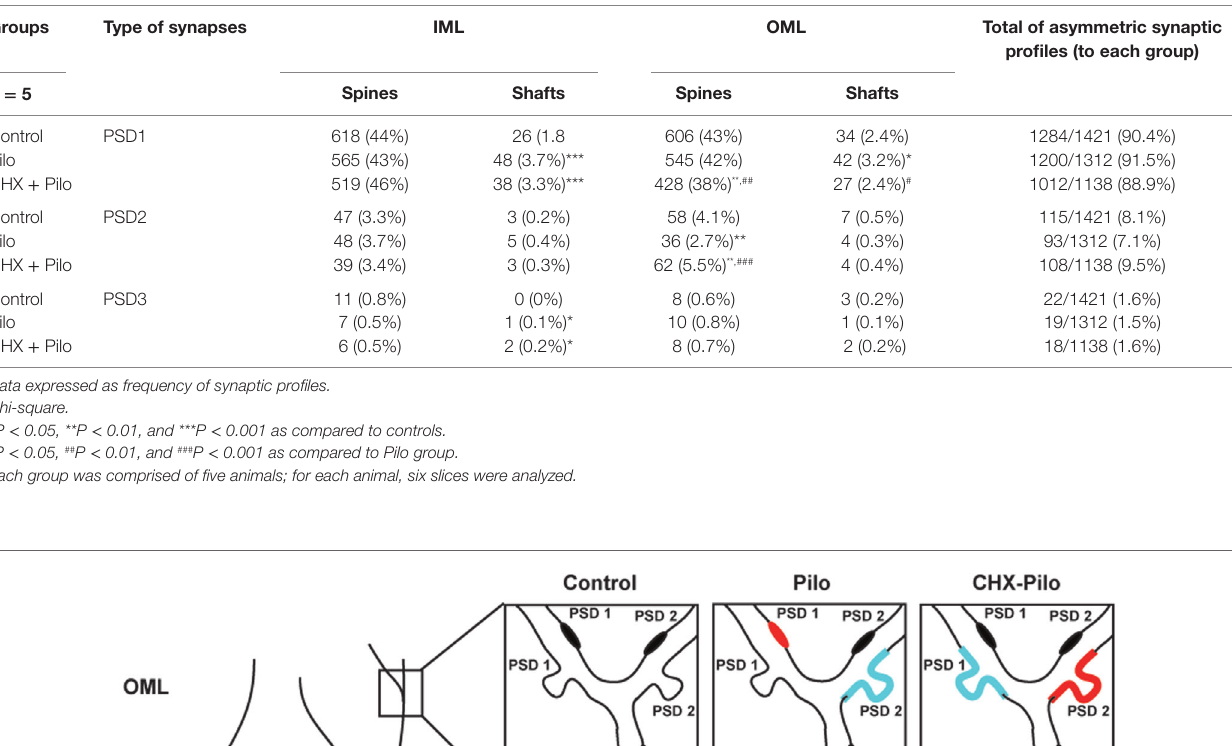
TaBle 2 | Frequency of dendritic spines and dendritic shafts (PsD1, 2, and 3) in the dentate molecular